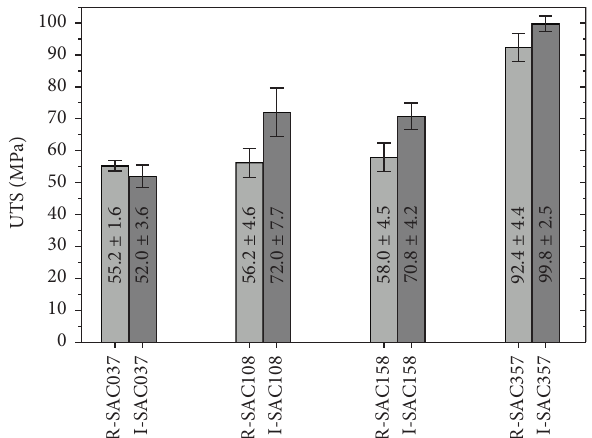
Figure 8: Ultimate tensile strength of soldered joints, prefix R, reflow soldered by hot plate and I, soldered by induction